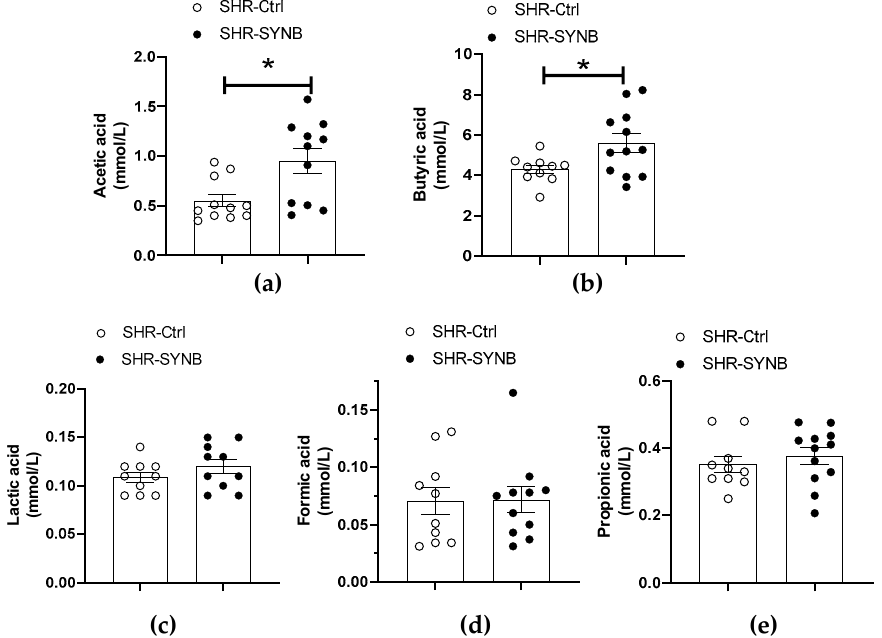
Figure 2. Levels of acetic ( a ), butyric ( b ), lactic ( c ), formic ( d ) and propionic ( e ) acids in fecal samples from SHR-Ctrl and SHR-SYNB animals. Results (Mean ± S.E.M.) are expressed in mmol/L. n = 10–12 animals each group. * p < 0.05 (Student’s t -test).